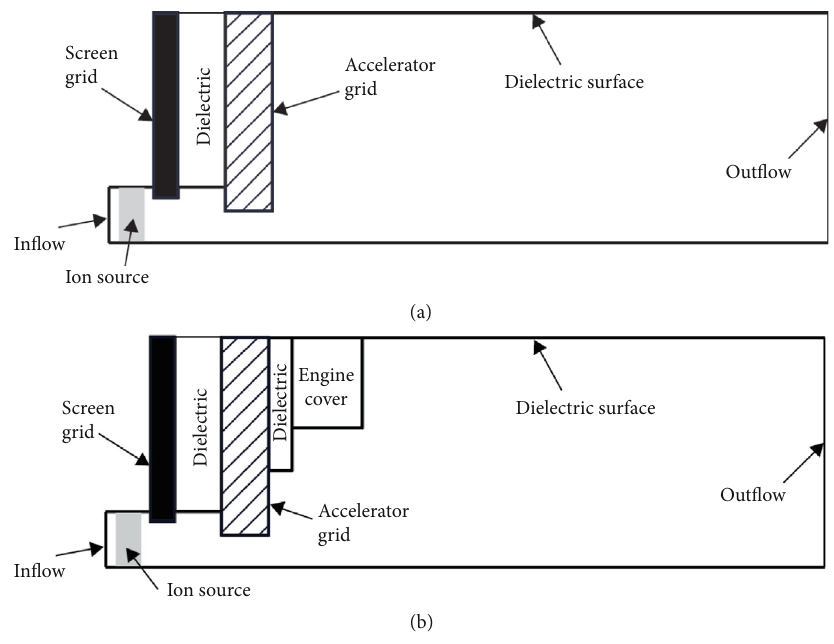
Figure 2: Computational domains with (b) and without (a) metal engine cover. Table 1: Grid parameters used in the simulation.